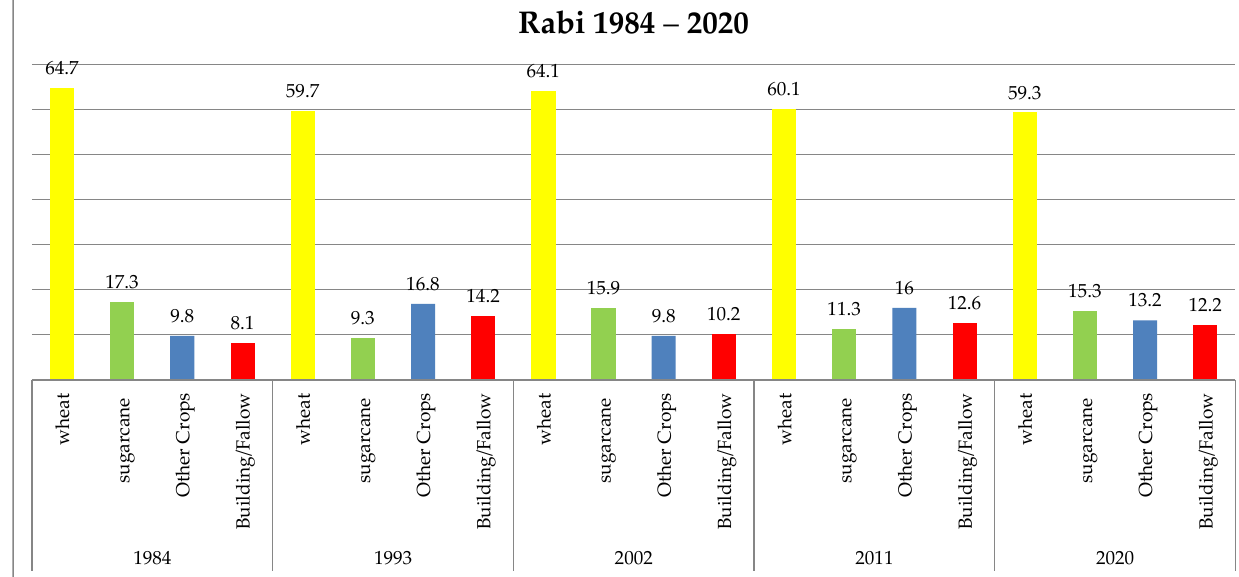
Figure 5. The cultivated area of major crops during Rabi seasons in District Vehari. In Kharif seasons, cotton was a key crop in District Vehari, with a total cropped land from 40.2% in 1984 to 31.1% in 2020. Cotton area decreased by 9.1% from 1984 to 2020 in District Vehari (Figure 6). The Rice area was observed to cover 14.3% and 18% during 1984 and 2020, respectively, in the study area. The cultivated area under rice increased by al- most 4% from 1984 to 2020. Another crop area, maize, was observed at 16.5% and 26.8% between 1984 and 2020 in the Kharif season (Figure 7). In the study area, the sugarcane area was observed at 17.3% and 15.3% during 1984 and 2020, respectively. The cultivated area under sugarcane decreased by almost 2% from 1984 to 2020. The building/fallow land increased from 9.1% to 10.2% from 1984 to 2020 in the study area.